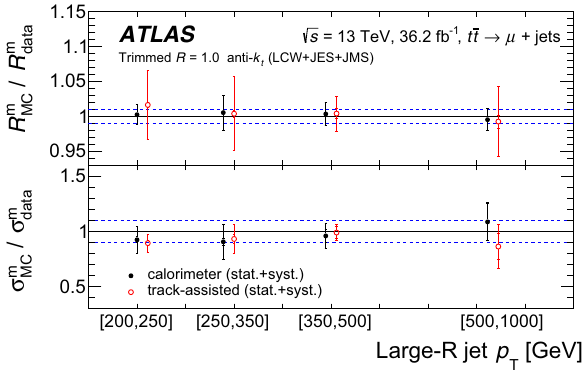
Fig. 20 Summary of the in situ measurements of the large- R jet mass response in t ¯ t events with a lepton+jets final state as a function of the large- R jet transverse momentum p T . The large- R jet p T is corrected using the simulation calibration, η -intercalibration, and a combination of in situ direct balance techniques. The closed circles correspond to the JMS and JMR of trimmed large- R jets reconstructed from calorimeter clusters. The open circles represent the equivalent result for the track- assisted mass. The dashed lines, corresponding to ± 1% for the JMS and ± 10% for the JMR, are drawn for reference. The results in the first two p T bins (200 GeV < p T < 250 GeV and 250 GeV < p T < 350 GeV) correspond to a sample of high- p T W bosons, and the highest two bins (350 GeV < p T < 500 GeV and 0.5 TeV < p T < 1 TeV) correspond to high- p T top quarks. In each subsample, the JMS and JMR are extracted simultaneously in a two-parameter fit to the mass distribution. The statistical and total uncertainties are indicated with the small and large error bars on the data points,